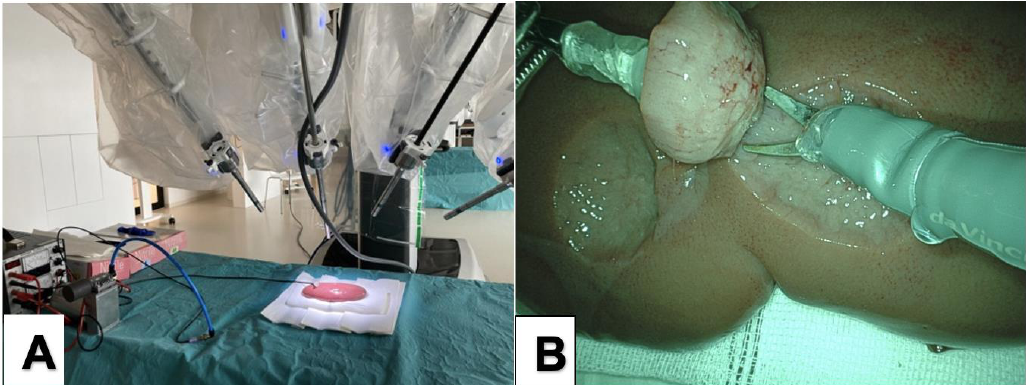
Figure 2. ( A ) Setup of the experiments with the daVinci Xi® system. ( B ) the THD was manipulated with the “Pro Grasp” Instrument, and resection was performed with the “Monopolar Scissors”.